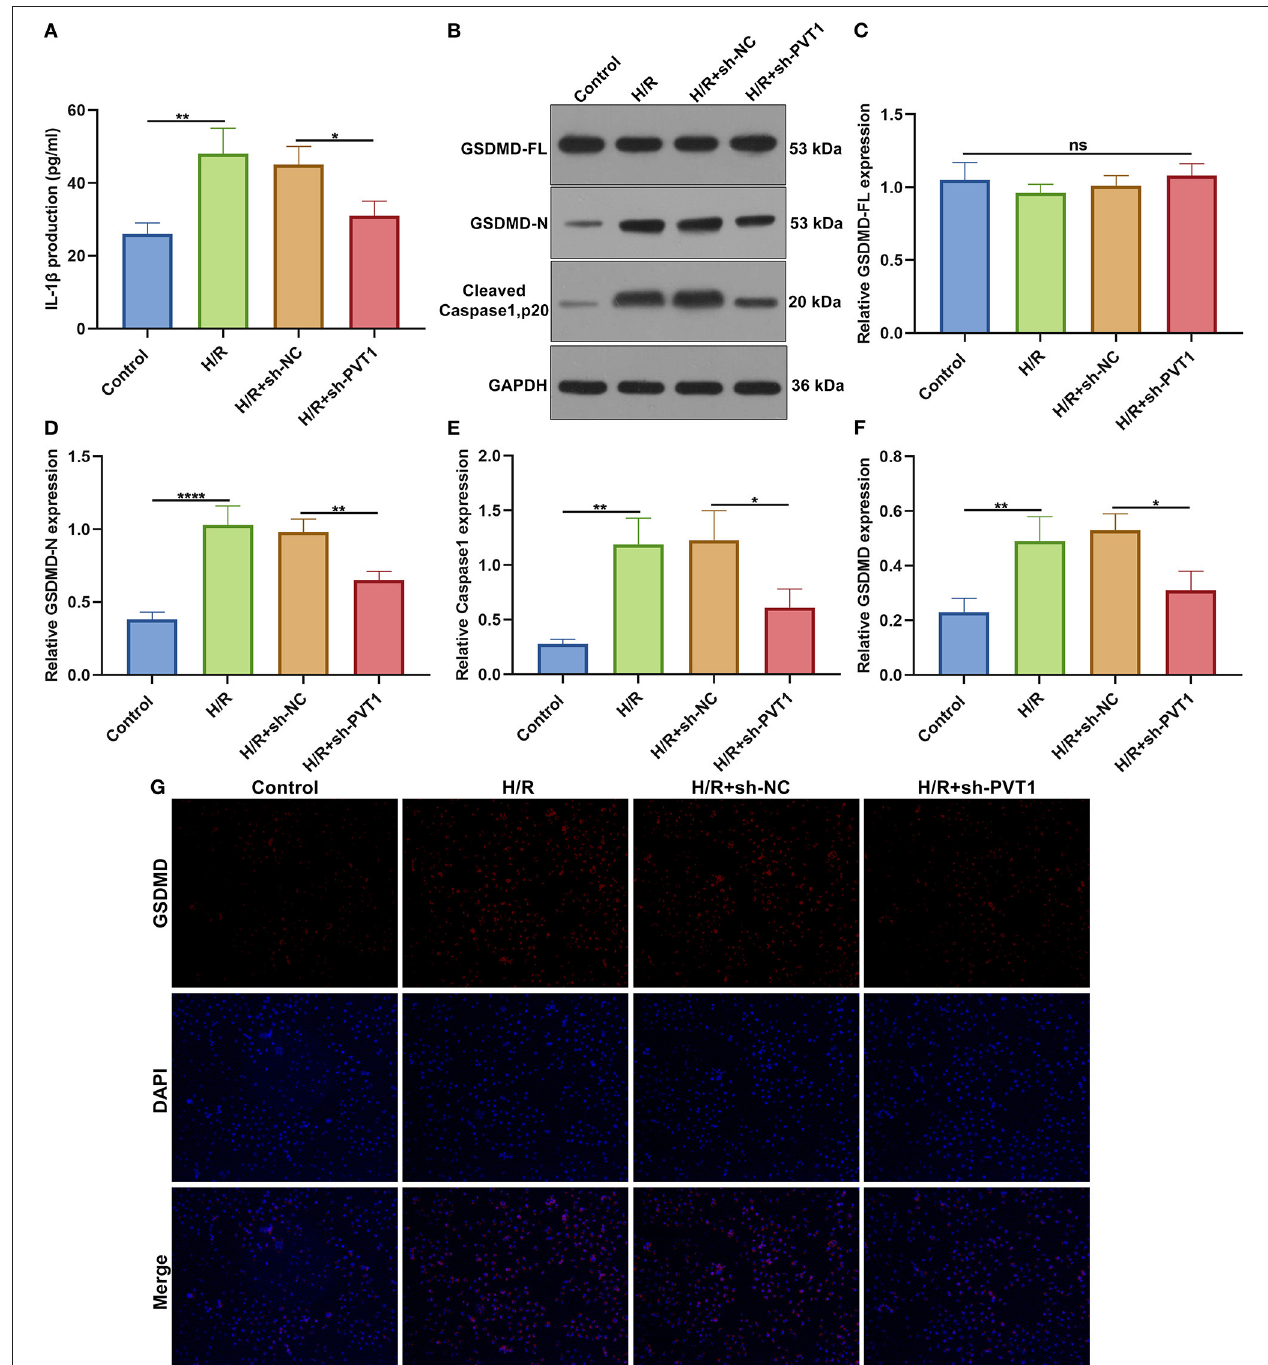
FIGURE 7 | LncRNA PVT1 knockdown ameliorates H/R-induced pyroptosis in cardiomyocytes. (A) ELISA for the levels of IL-1 β production in H9C2 cells in four groups: control, H/R, H/R + sh-NC, and H/R + sh-PVT1 groups. H9C2 cells in the H/R, H/R + sh-NC, and H/R + sh-PVT1 groups were treated by H/R for 4h. For the H/R + sh-NC or H/R + sh-PVT1 groups, H9C2 cells (5 × 10 4 ) were transfected by 1 µ g sh-NC or 1 µ g sh-PVT1 for 48h. No treatment was done for H9C2 cells in the control group. (B–E) Western blot for (C) GSDMD-FL, (D) GSDMD-N, and (E) cleaved Caspase1 (p20) expressions in H9C2 cells in above groups. (F,G) Immunofluorescence for the expression of GSDMD in H9C2 cells in above groups. Each experiment was repeated three times. Ns: not significant; * p < 0.05; ** p < 0.01; **** p < 0.0001.